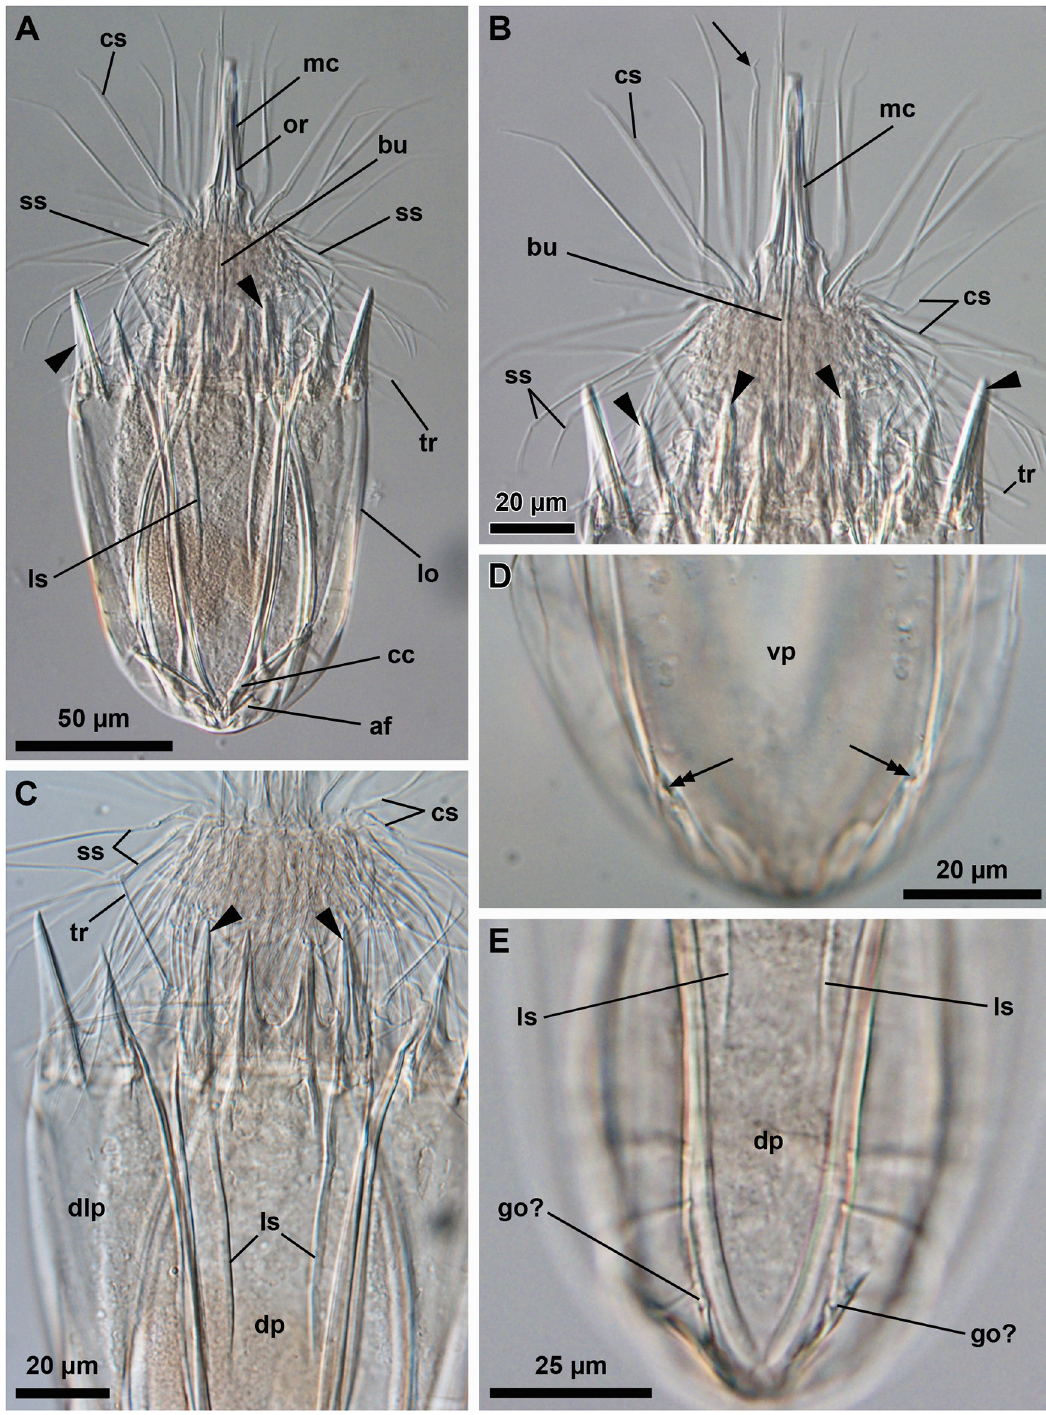
Fig 4. Light micrographs of the allotypic adult female of Nanaloricus valdemari sp. nov. Anterior faces up in all aspects. (A) Overview of the specimen, dorsal view. Note that the mouth tube is not fully extended. Note also the pair of longitudinal stripes (ls) spanning the anterior two thirds of the dorsal plate of the lorica. (B) Close-up of the anterior region of the specimen, dorsal view. Arrow points to the two most distal segments of a clavoscalid. (C) Close-up of the introvert, neck and anterior region of the abdomen, dorsal view. (D) Posterior region, ventral view. Double-headed arrows point to large pores (gland outlets?) situated on the posterior region of the ventral plate. (E) Posterior region, dorsal view. Note the putative gonopores (go?) located on the